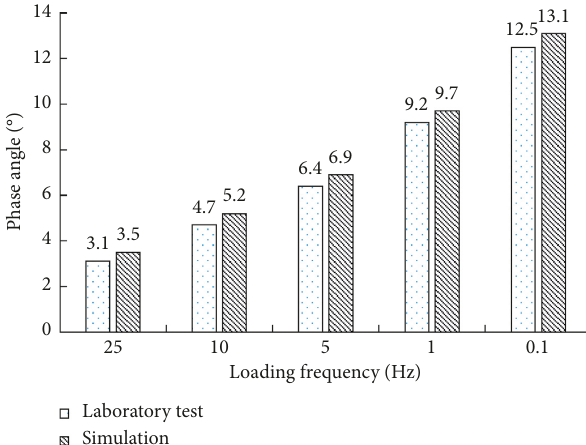
Figure 14: Phase angle prediction based on the proposed